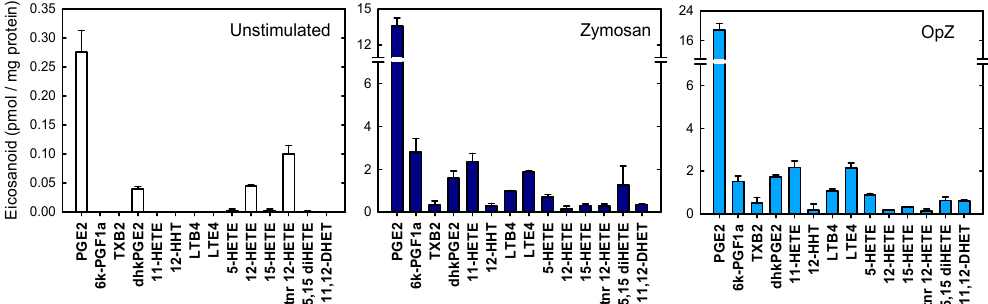
Figure 2. Eicosanoid production by macrophages. The cells were either unstimulated (open bars) or stimulated with zymosan (dark blue bars) or OpZ (light blue bars) for 8 h. Extracellular media were removed and analyzed for eicosanoid levels by mass spectrometry. The data are expressed as mean values ± S.E.M. ( n = 6). PGE2, prostaglandin E 2 ; 6k-PGF1a, 6-ketoprostaglandin F 1 α ; TXB2, thromboxane B 2 ; dhkPGE2, 13,14-dihydro-15-ketoprostaglandin E 2 ; 11-HETE, 11-hydroxy-eicosatetraenoic acid; 12-HHT, 12- hydroxyheptadecatrienoic acid; LTB4, leukotriene B 4 ; LTE4, leukotriene E 4 ; 5-HETE, 5-hydroxyeicosatetraenoic acid; 12-HETE, 12-hydroxyeicosatetraenoic acid; 15-HETE, 15-hydroxyeicosatetraenoic acid; tnr-12-HETE, tetranor-12-hydroxyeicosatetraenoic acid; 5,15-diHETE, 5,15-dihydroxyeicosatetraenoic acid; 11,12-DHET, 11,12-dihydroxyeicosatrienoic acid. To identify the PLA 2 form(s) involved in AA release in macrophages responding to zymosan and OpZ, we took advantage of the use of the most potent and selective inhibitors currently available to block the different PLA 2 s present in macrophages [59,60]. Pyrrophenone, a cytosolic group IVA PLA 2 (cPLA 2 α ) inhibitor, is at least 3 orders of magnitude more potent for cPLA 2 α than for calcium- independent or secreted PLA 2 s [61–63]. The fluoroketone FKGK18 is at least 200 and 400 times more